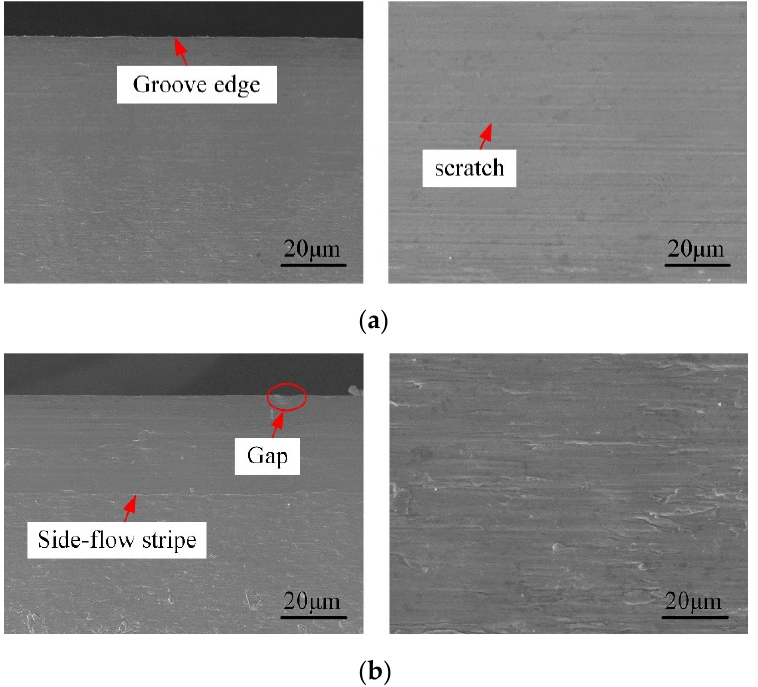
Figure 10. Surface morphology of side-walls of deep-and-narrow micromilled grooves. ( a ) Self-man- ufactured PCD cutter; ( b ) Carbide cutter.